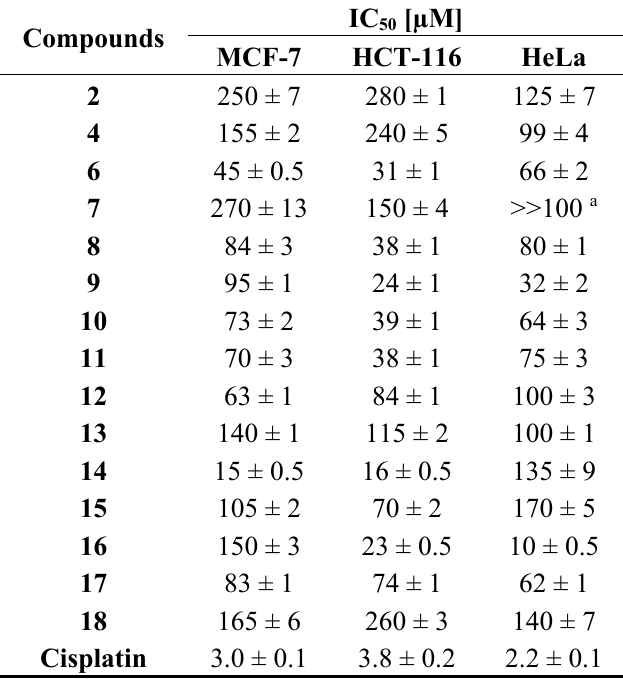
Table 1. Cytotoxicity of compounds 2 , 4 and 6 ‒ 18 toward human cancer cell